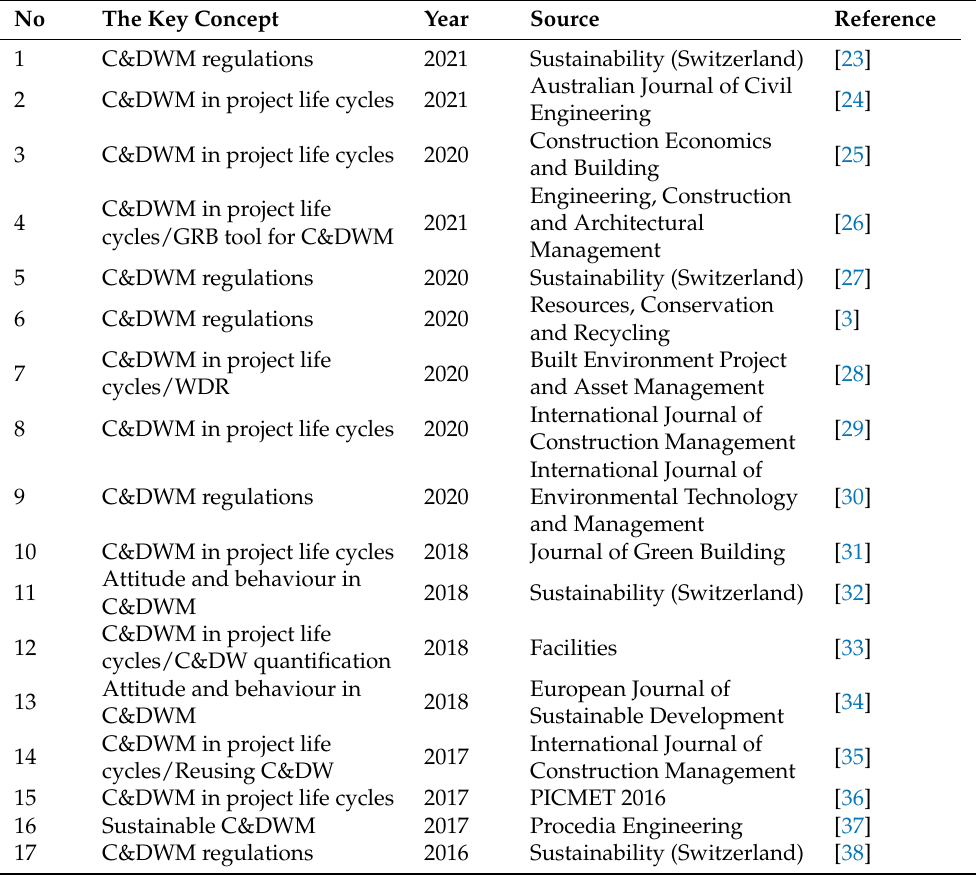
Table 1. Construction and demolition waste management research backgrounds in Australia